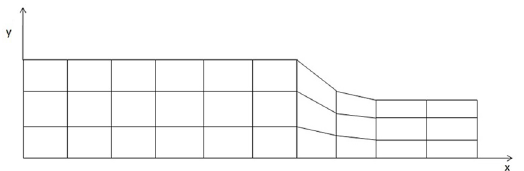
Figure 1. Example of mesh in flat